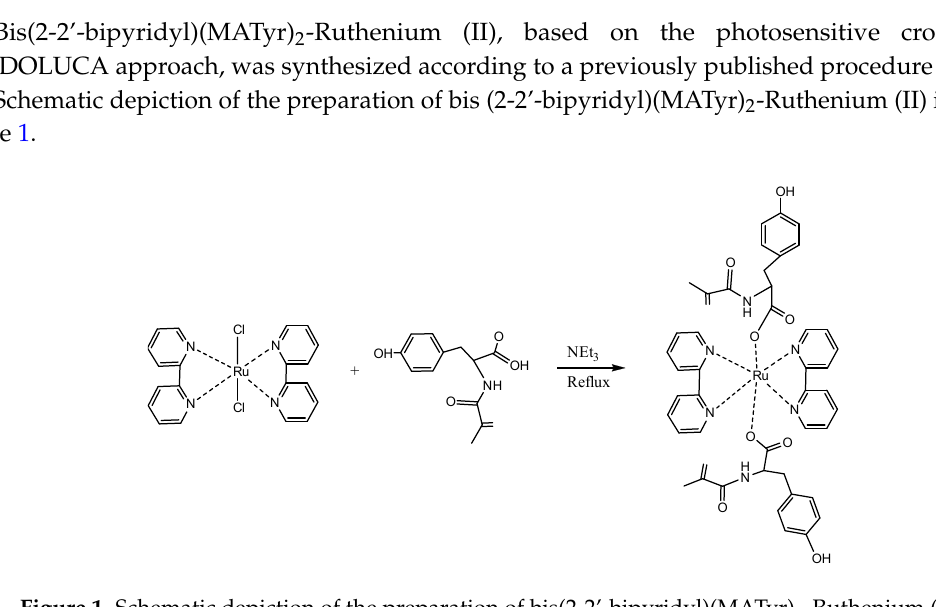
Figure 1. Schematic depiction of the preparation of bis(2-2’-bipyridyl)(MATyr) 2 -Ruthenium (II).